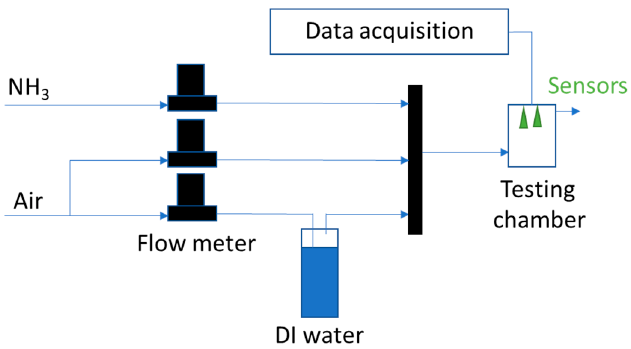
Figure 1. Schematic of the gas sensing system.